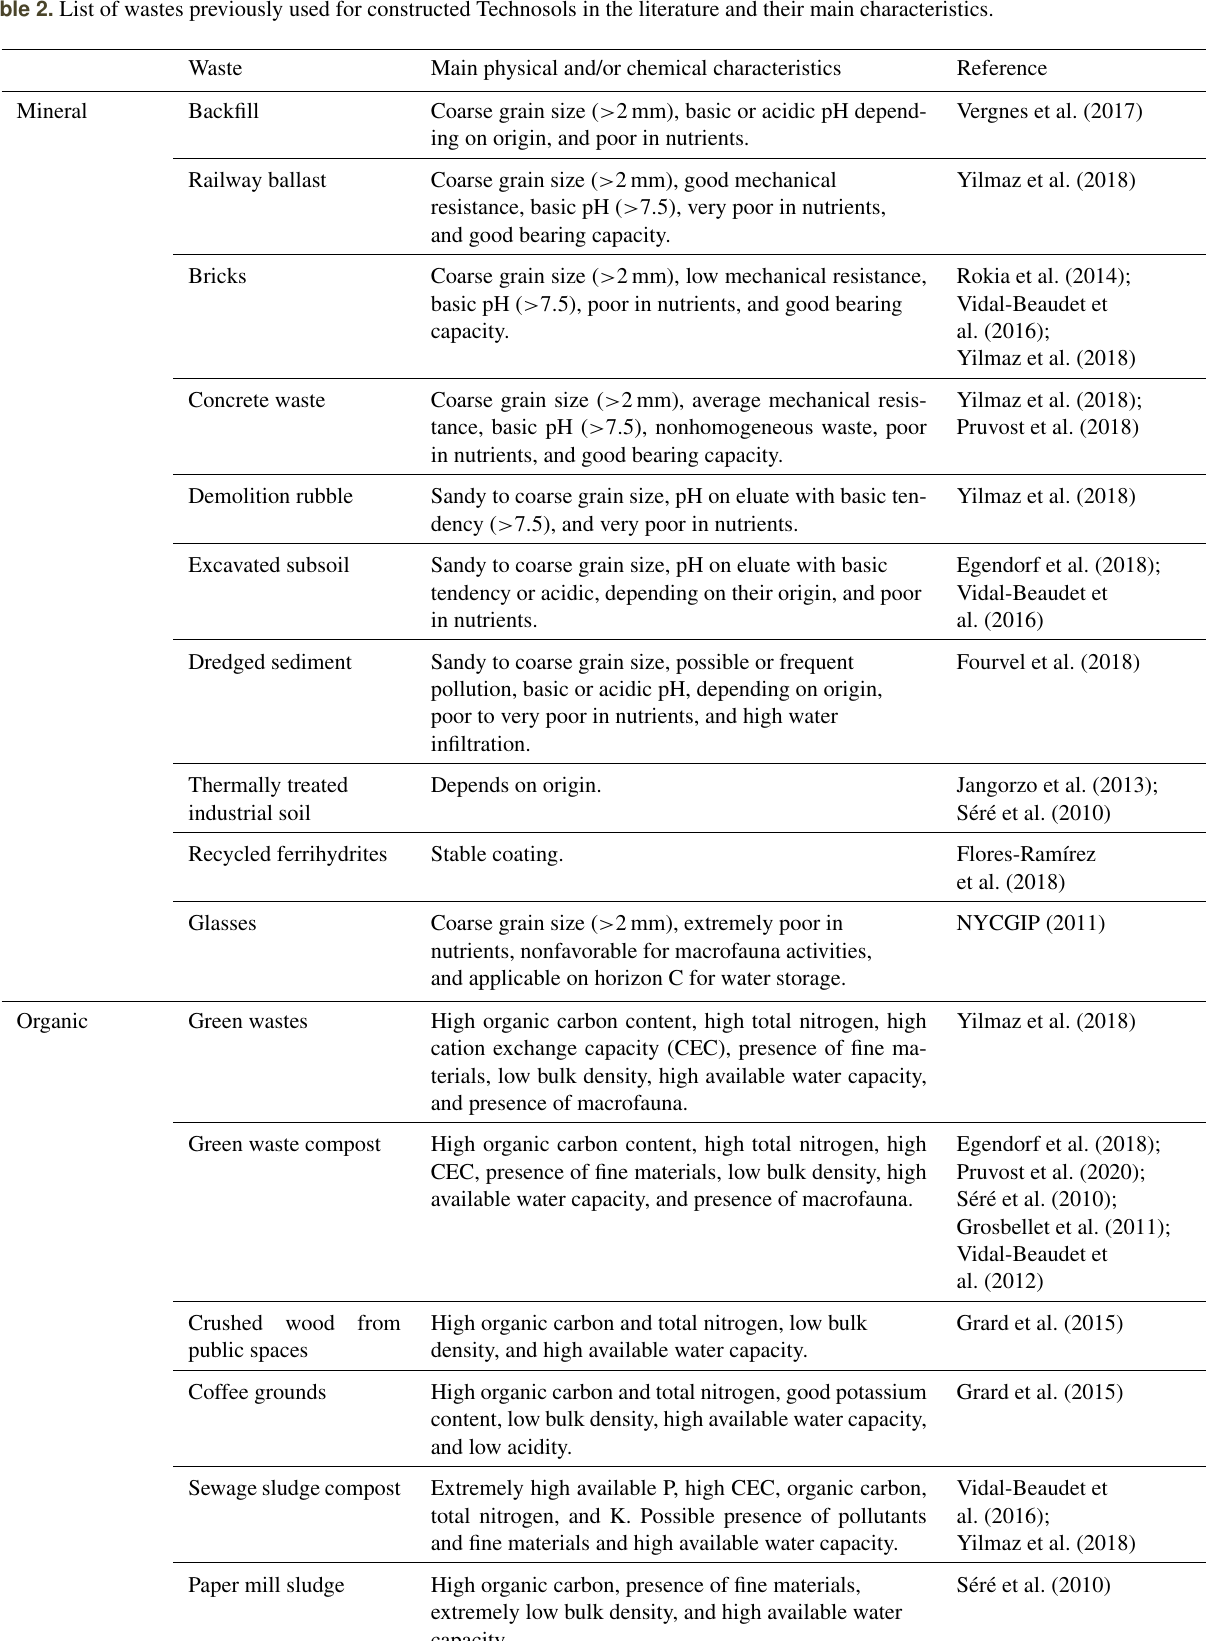
Table 2. List of wastes previously used for constructed Technosols in the literature and their main